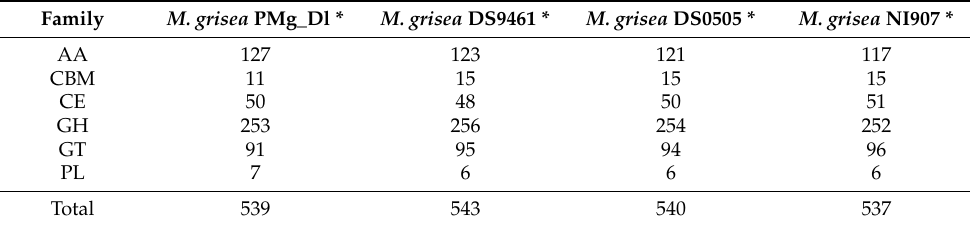
Table 3. Comparative CAZyme family profile in M. grisea PMg_Dl, P. oryzae DS9461, M. oryzae DS0505, and M. oryzae